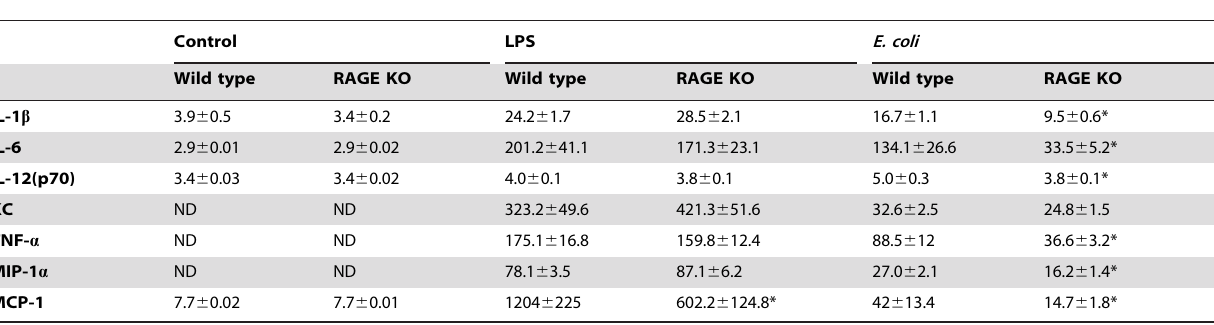
Table 1. Cytokine profile of BALF from wild type and RAGE KO